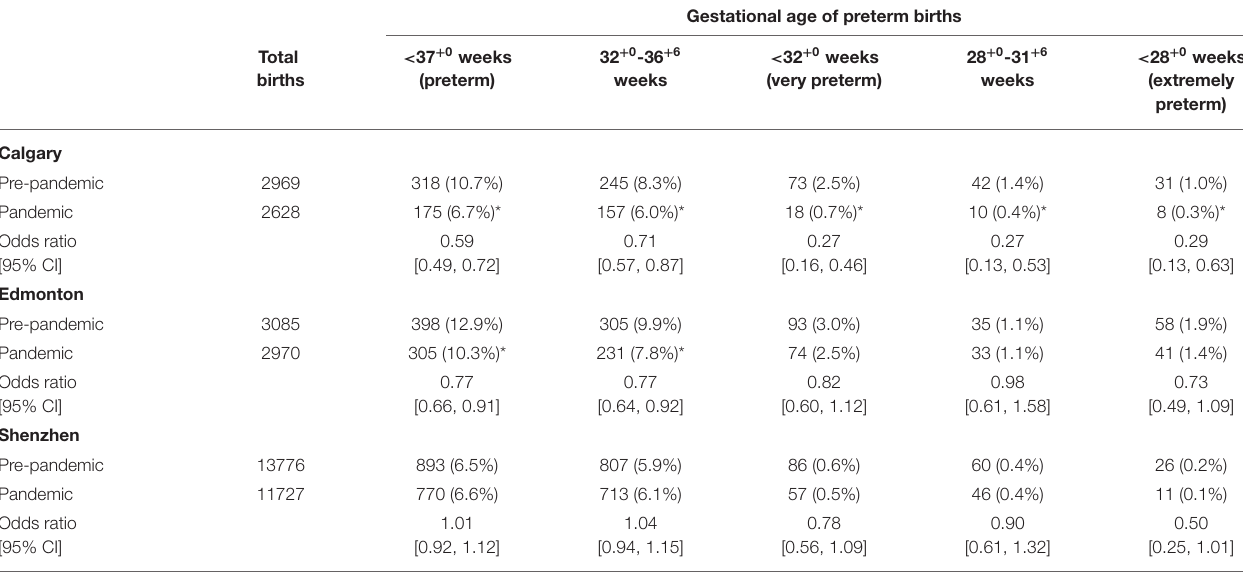
TABLE 1 | Birth rates of different gestations and odds ratio [95% confidence interval (CI)] during pre-pandemic and pandemic COVID-19 epochs in Calgary, Edmonton and